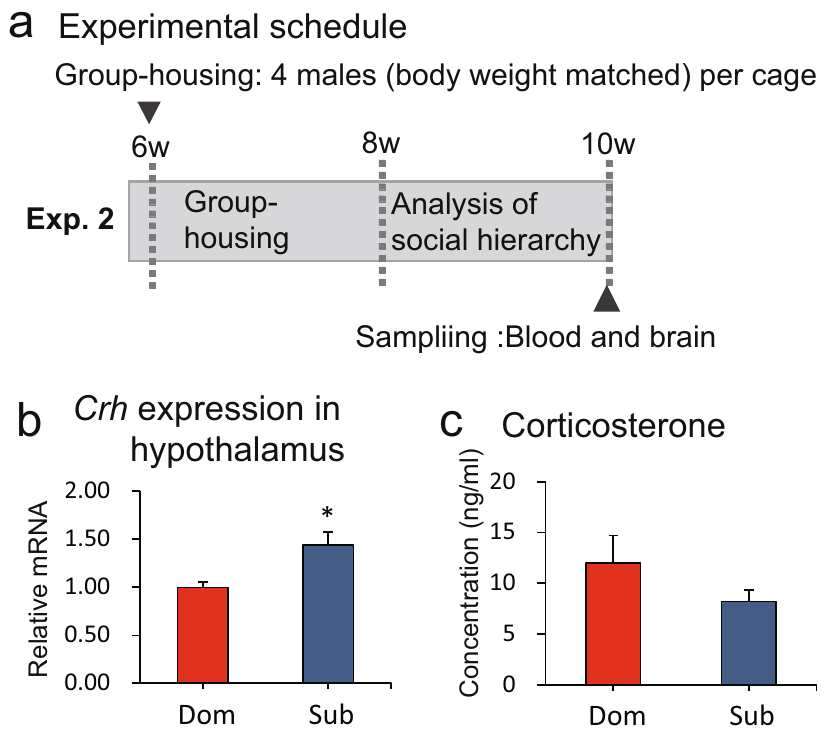
Figure 3. Comparison of stress levels in dominant and subordinate males. The hypothalamic expression of Crh and serum concentrations of corticosterone in dominant (Dom) and subordinate (Sub) males were compared. ( a ) In Experiment 2, blood samples and the brain were collected when the mice were aged 10 weeks, and the hormone concentrations and mRNA transcript levels were determined. Blood ( n = 16 cages) and brains were collected from different sets of animals ( n = 16 cages and n = 8 cages, respectively). ( b ) The Crh mRNA transcript level in the hypothalamus ( * P < 0.05). ( c ) Concentrations of corticosterone in serum, measured to assess basal stress levels in the mice in their home